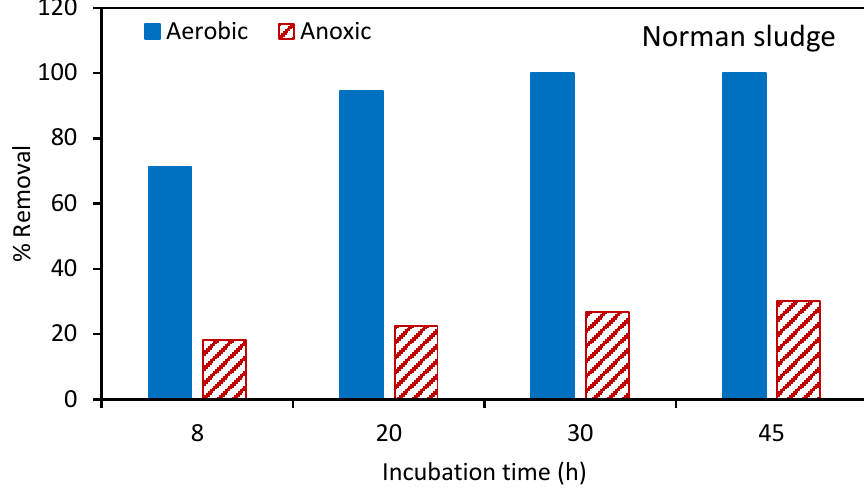
Figure 8. Percentage removal of atrazine in batch experiments where there is no mixing of the MLSS using Norman sludge. The total suspended solids (TSS) in aerobic and anoxic tanks was 7029 and 6024 ± 600 mg/L, respectively.